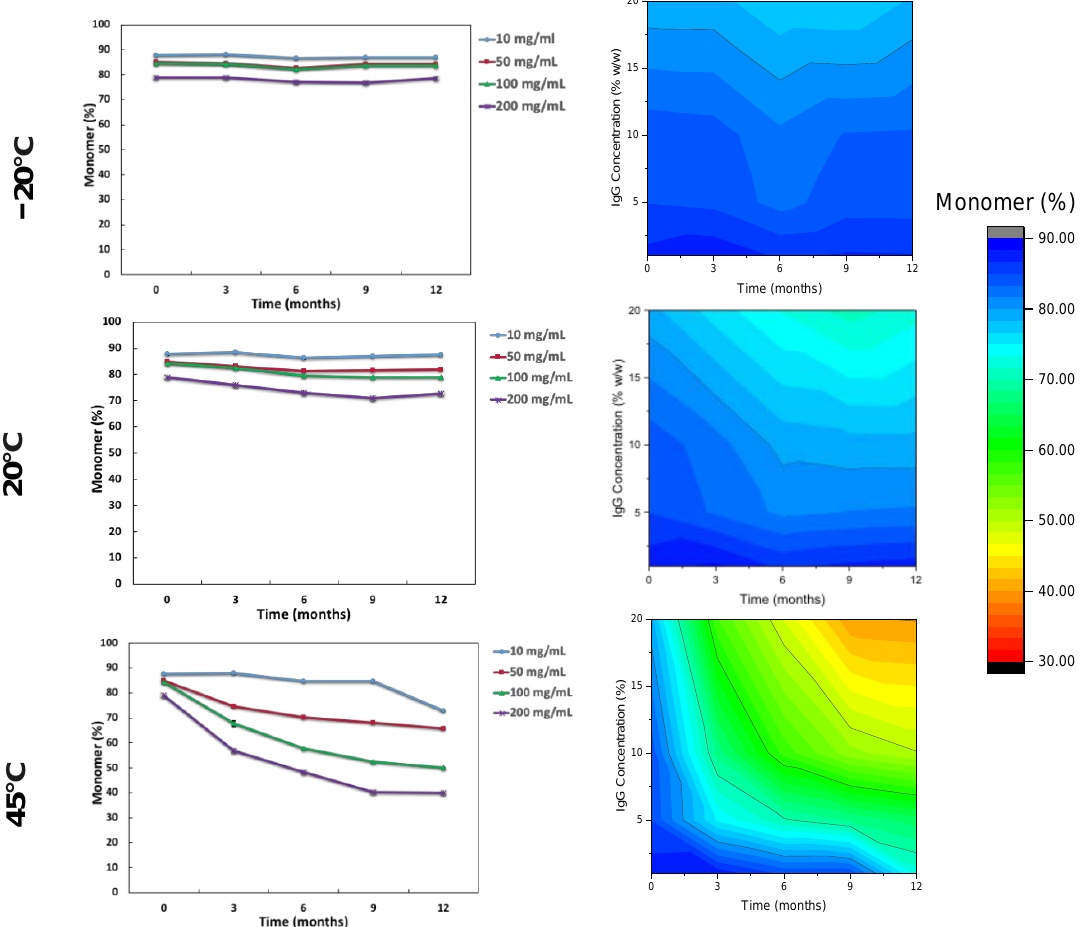
Figure 2. Average monomer content (%) over time for low to high concentration IgG with contour stability maps as measured by SEC-HPLC over 12 months stored at (from top to bottom) − 20 ◦ C, 20 ◦ C and 45 ◦ C ( n = 3 vial replicates). Error bars at 95% confidence intervals are too small to be seen.